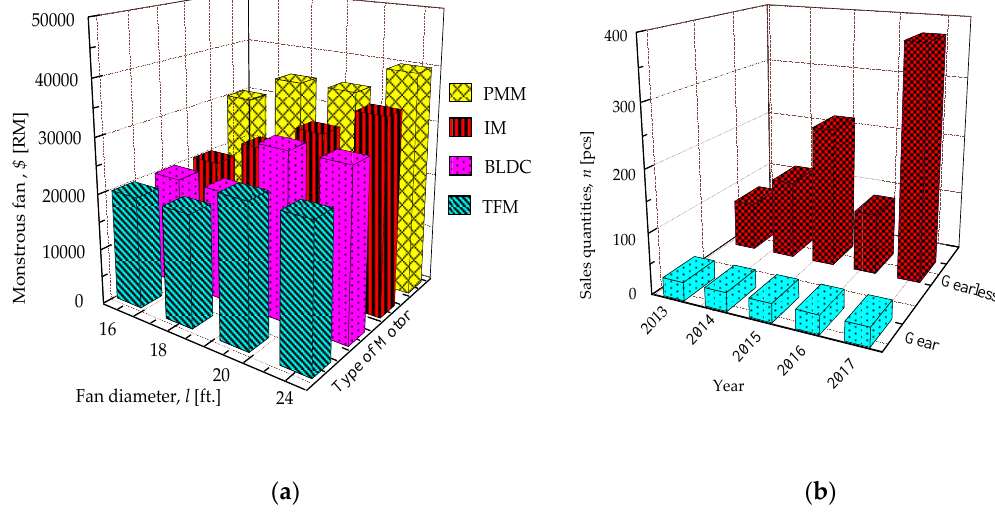
Figure 10. Technology and price competitiveness ( a ) Price ( b ) Fan Technology .